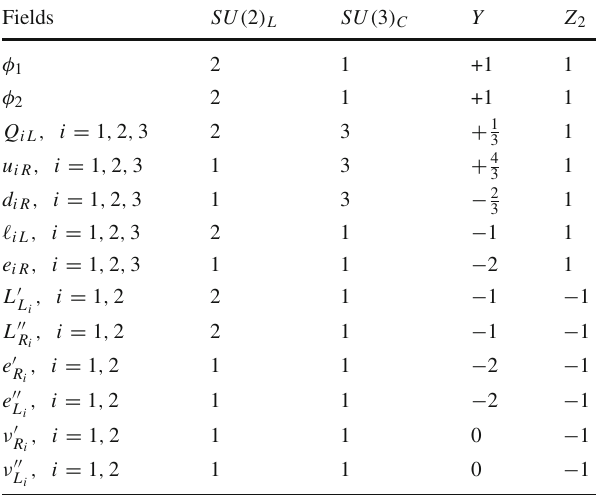
to the particles in the model